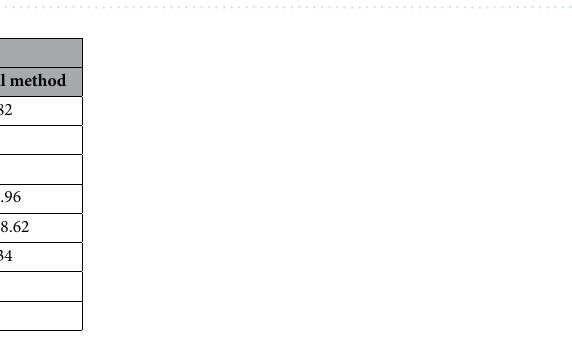
Table 3. The PK parameters of adalimumab for 10 rats after they receive one subcutaneous injection of 0.5 mg adalimumab. a Each parameter was performed with a variance test, and the P value was bigger than 0.05.